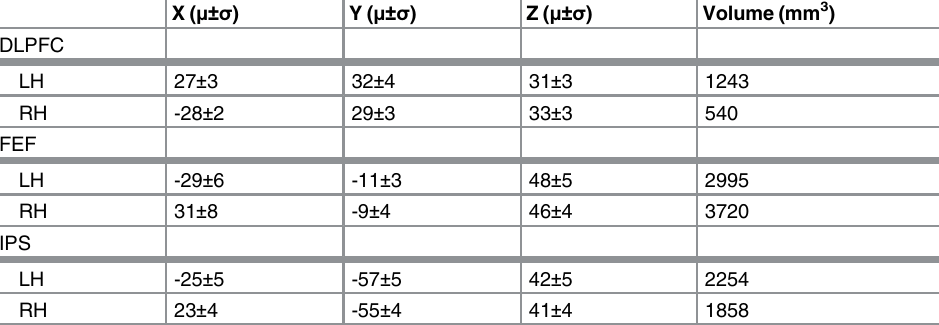
Table 1. Talairach coordinates ( μ ± σ , x, y, z, volume) averaged across six participants included in the